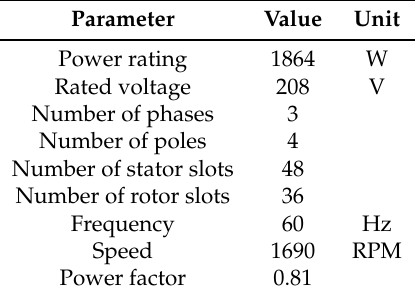
Table 1 gathers specifications of the WRIM used in this work. Table 1. Specifications of the